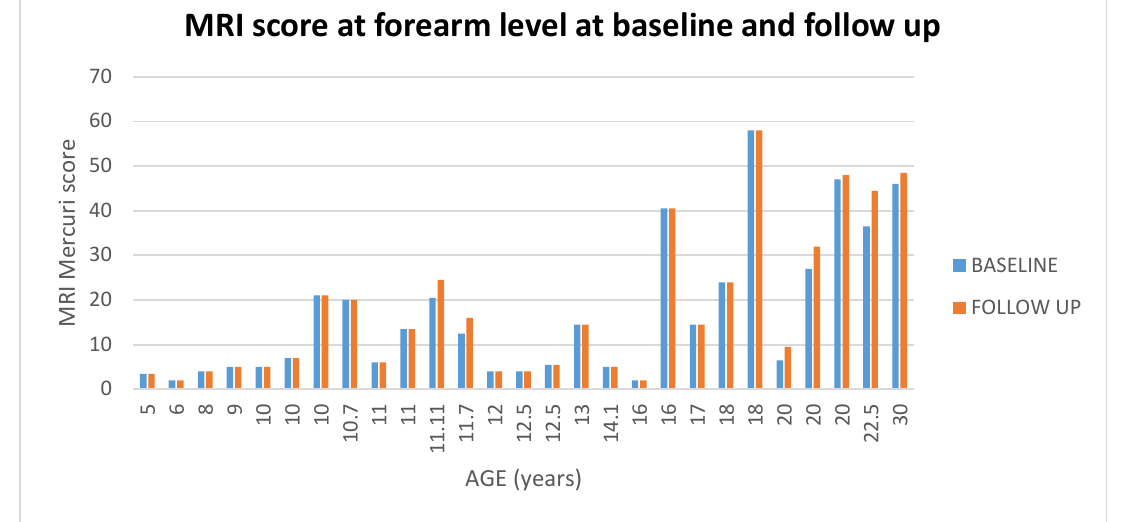
Figure 10. showed scores in muscle MRI at distal level at baseline and at follow up according to age.